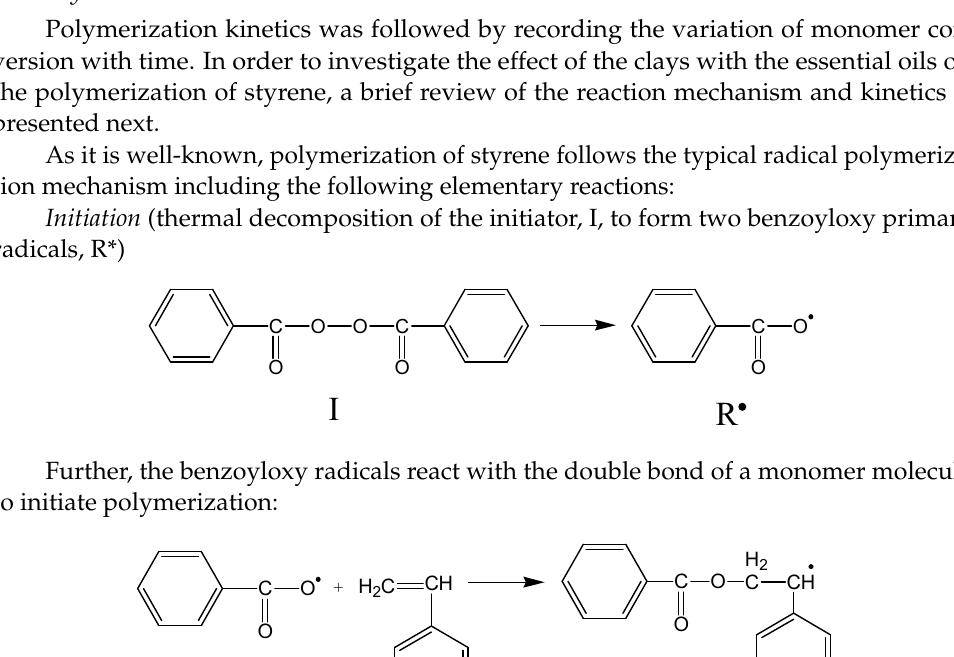
Figure 3. FTIR spectra of neat PS (a) and PS/orgMMTEO nanocomposites in the wavenumber range 4000-3200 cm -1 (a) and 1150-650 cm -1 (b).